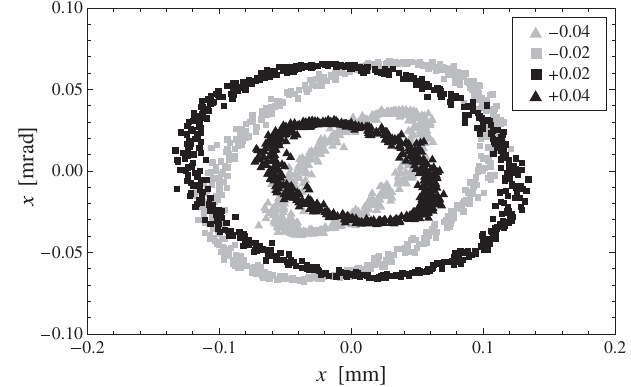
FIG. 5. Phase space ellipses of driven oscillations at an inter- action point in the Tevatron (B0) when (cid:3) d ¼ (cid:5) 0 : 02 and (cid:5) 0 : 04 . Because the Courant-Snyder-like parameters of driven oscilla- tions (cid:1) d ð s Þ , (cid:9) d ð s Þ , and (cid:10) d ð s Þ depend on (cid:3) d , not only the areas but also the shapes of the ellipses are